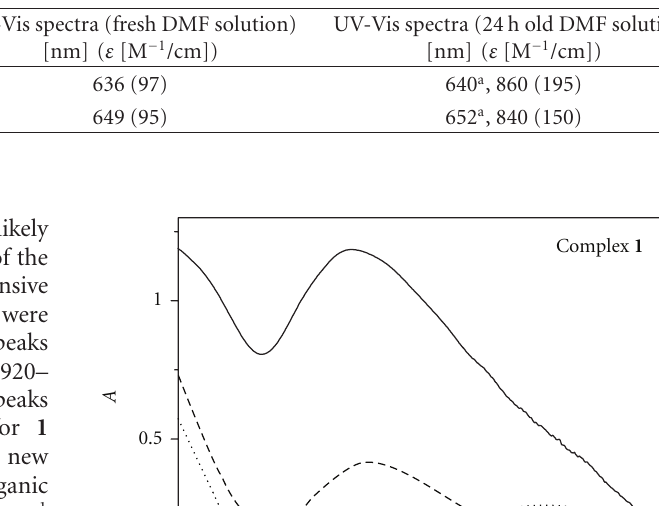
Table 1: Magnetic and electronic spectral data for complexes 1 and 2 .